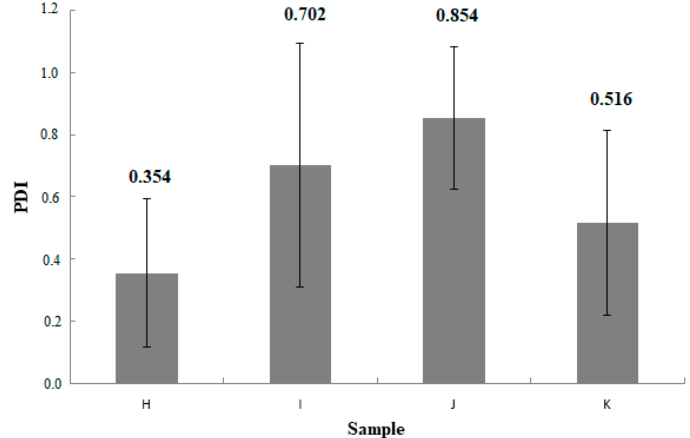
Figure 3. Obtained results for measurements of PDI of samples, n = 5, the Y-bars represent the standard deviation.